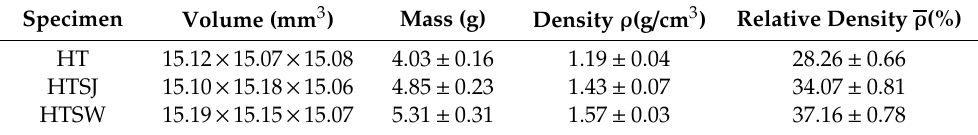
Table 3. Measured parameters of the printed